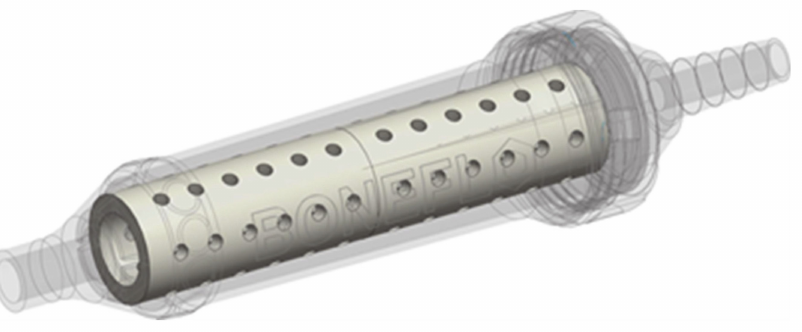
Figure 2. Illustrates a CAD-model of a suction handle for intraoperative stromal cell enrichment filled with a ceramic scaffold (©EFRE-Projekt Boneflo, Department of Orthopaedics and Trauma Surgery University of Duisburg-Essen, Germany).